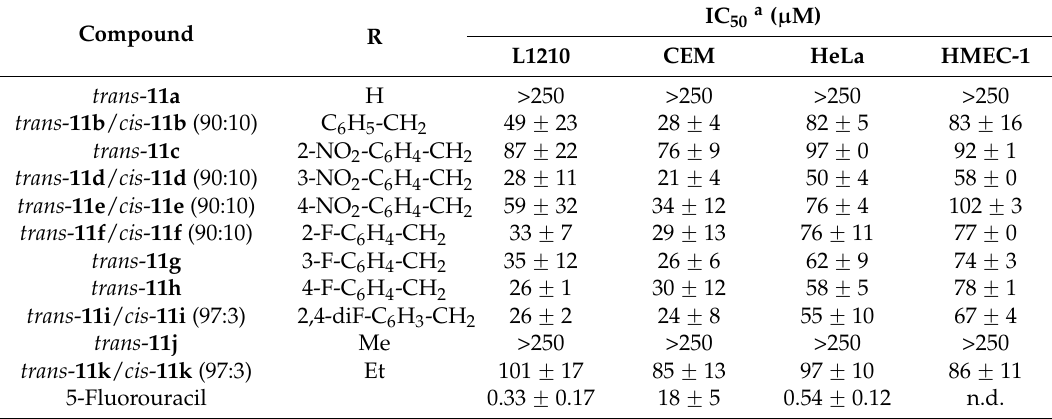
Table 4. Inhibitory effect of the tested compounds against the proliferation of murine leukemia (L1210), human T-lymphocyte (CEM), human cervix carcinoma (HeLa) and immortalized human dermal microvascular endothelial cells (HMEC-1).